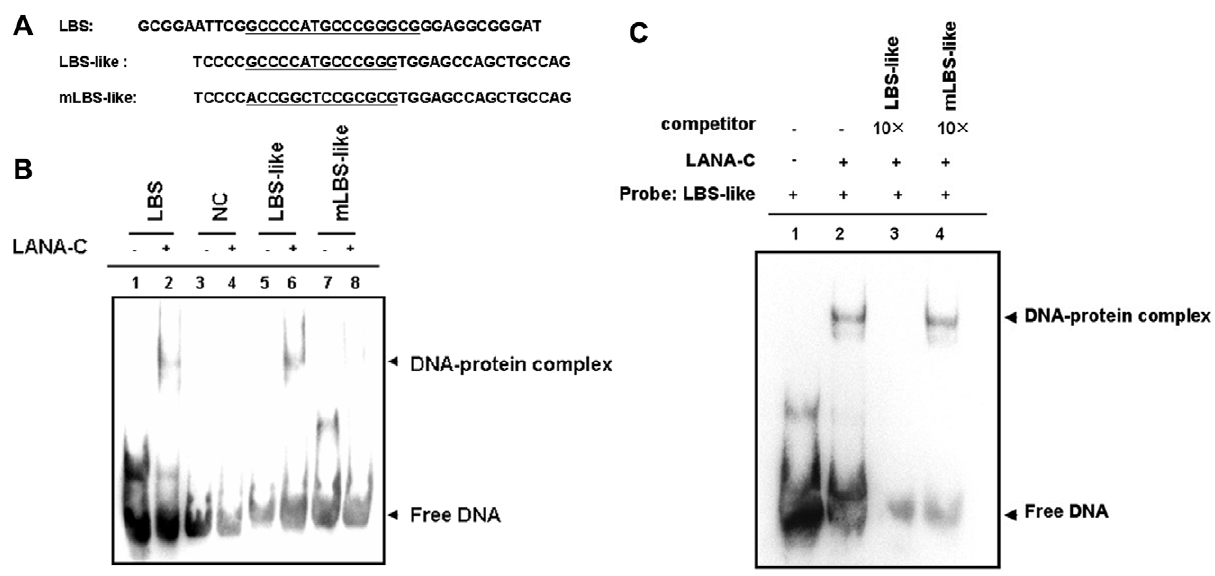
Figure 4. LANA binds to the IL-22R1 promoter in vitro. ( A ) The aligned sequences of DNA fragments from TR DNA, wild type and mutant IL- 22R1 promoters which contain LBS, the wild type LBS-like sequence and scrambled-mutant DNA sequence (underlined) [38]. The nucleotide sequences represent the probe sequences used in the EMSA and were labeled with biotin. ( B ) LANA can bind to the LBS-like DNA sequence in IL- 22R1 promoter. Probes as indicated were incubated for 20 min with or without purified LANA-C (a.a. 951–1162). NC, a DNA fragment derived from the sequence in M13 DNA, used as a negative control for LANA binding. ( C ) The binding of LANA to the wild type LBS-like sequence is specific. A 10- fold excess of cold competitor or mutant competitor DNA was added to compete the reaction between WT LBS-like and LANA. The upper and lower arrows indicate the LANA-specific binding band and free probe.